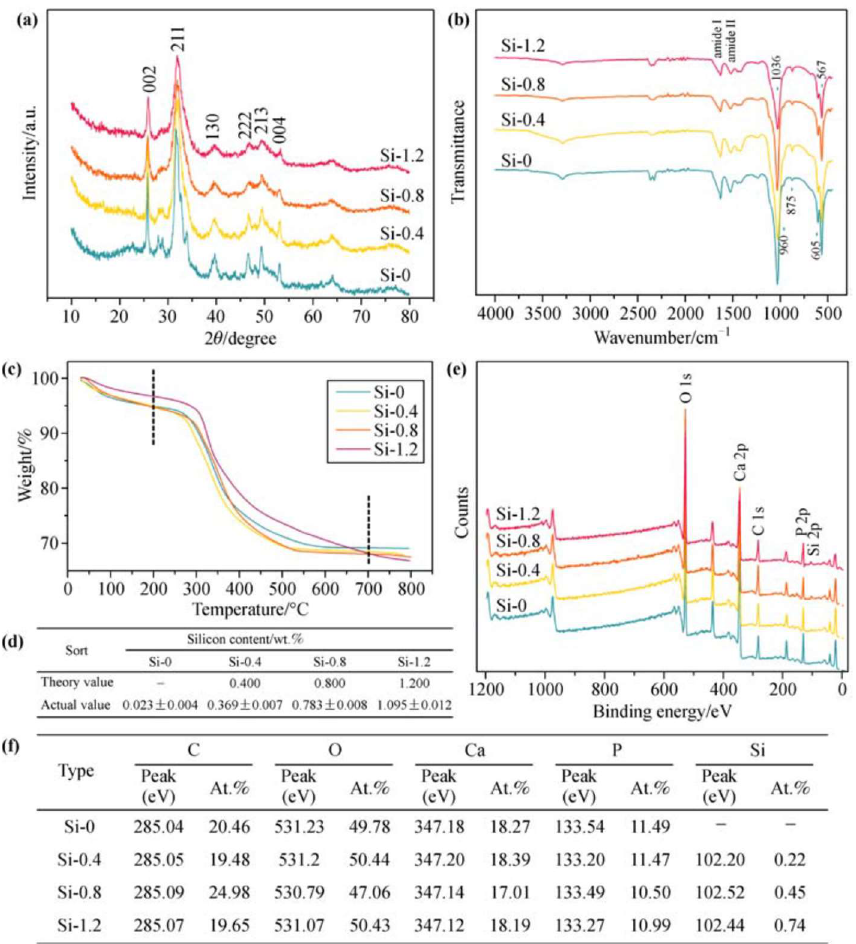
Figure 3. Characterization of materials. ( a ) XRD analysis showing that both Si-free and Si-doped HA groups exhibited the main diffraction peaks of HA in comparison to the HA standard card (JCPDS-PDF 09-0432). ( b ) FTIR analysis indicating that each group of template-induced materials displayed the typical phosphate group and main functional groups of amides I and II due to the presence of organic protein templates. ( c ) Thermogravimetric (TGA) analysis confirming that the template-induced materials were organic–inorganic composites consisting of 20%–30% organics and 70%–80% inorganics. ( d ) Si-molybdenum blue spectrophotometry confirming that the actual value of silicon content was quite close to the theory value. ( e , f ) X-ray photoelectron spectroscopy (XPS) analysis showing the typical peaks of Ca and P in a Si–O group and the typical peaks of Si in Si-doped groups. The mole ratio of n(Ca)/n(P) or n(Ca)/[n(P) + n(Si)] of the sample was close to the theoretical value of HA (n(Ca)/n(P) = 1.67). Reprinted from [140], with permission from Springer Nature, 2017.